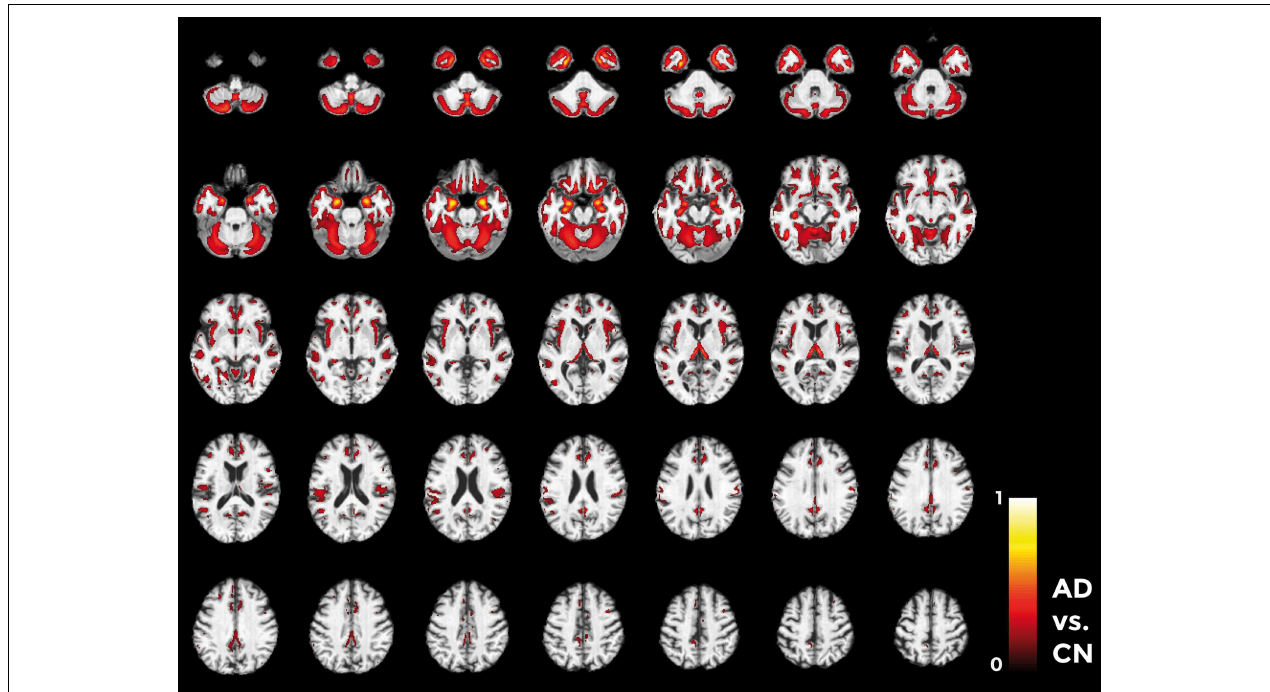
FIGURE 10 | Voxel-based pattern distribution map (axial view) for the classification between AD and CN. Voxel-based pattern distribution (normalized to a range between 0 and 1) is expressed according to the color scale (threshold = 50%) and superimposed on a standard stereotactic brain for spatial localization.